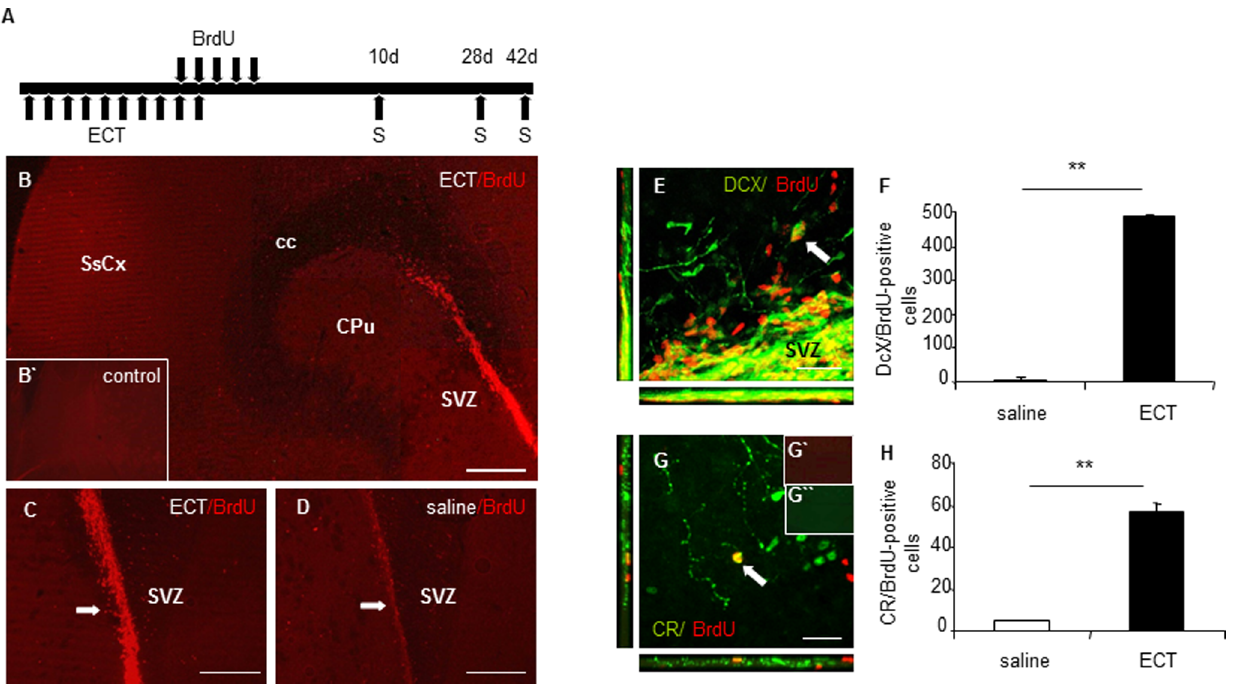
Figure 1. ECT significantly increases BrdU expression in the SVZ and the number of newborn DCX-positive neuroblasts and CR- positive interneurons in the rat striatum and nucleus accumbens. (A) Schematic representation of the ECT and BrdU applications and the analysis of animals (sacrification, S) 10d (migration) or 42d (differentiation) after the last BrdU injection (B–D) A significant increase in BrdU expression, indicative of intense cell proliferation, 10 days after ECT in the SVZ (arrows) (B, C) compared to saline-treated animals (D). BrdU expression was prominent in the SVZ and proximal areas and low in other areas (B). As expected, no specific staining was visible in control sections processed only with the secondary antibody (B`). (E,F) Significant increase in the number of DCX/BrdU-positive cells (green/red) in the medial striatum in ECT-treated animals compared to saline-treated rats 10d after the BrdU treatment, quantitative analysis in (F). (G) Example of a double-labelled CR/BrdU interneuron in the nucleus accumbens ( arrow ) 42d after the BrdU treatment. (G`, G`` ) No specific staining was visible in control sections processed only with the secondary antibodies. (H) Quantitative analysis of the CR/BrdU co-expression in ECT-treated vs. saline-treated animals. Statistical differences determined by Mann-Whitney U test (0.001 , **p , 0.01). Scale bars: B–D, 200 m m, E, G, 20 m m. SsCx, somatosensory cortex; cc, corpus callosum; CPu, caudate-putamen; SVZ, subventricular zone.